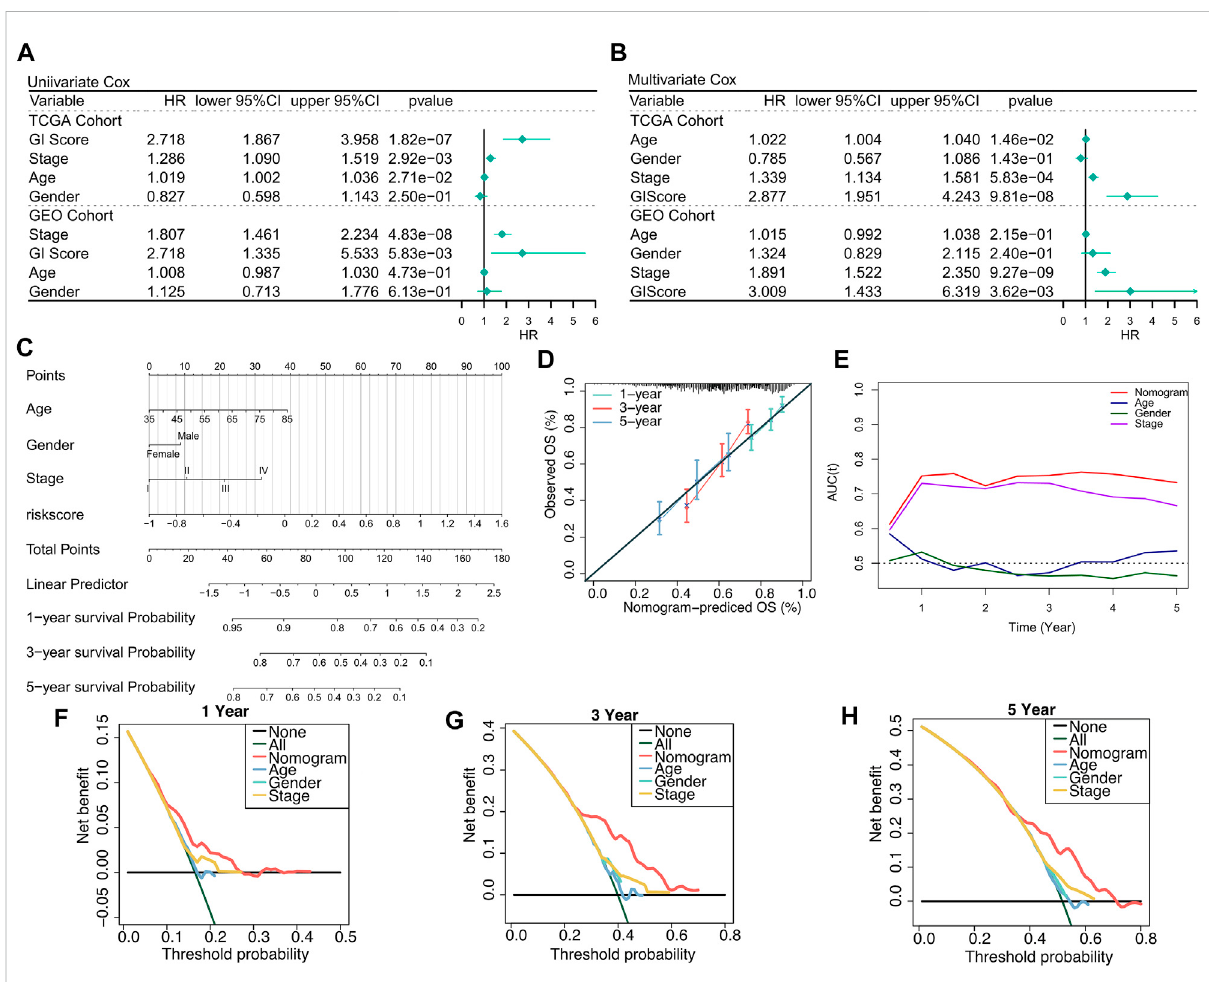
FIGURE 3 Verifying the GIS-related risk model. (A) Univariate Cox regression analysis of GIS and clinical features in the TCGA and GEO datasets. (B) Multivariate Cox regression analysis of GIS and clinical features in the TCGA and GEO datasets. (C) Nomogram based on the GIS model to quantify individualpatientrisk. (D) Nomogramcalibrationcurve. (E) tROCcurvesofnomogramandclinicalfeatures.NomogramDCAcurvesat1 (F) ,3 (G) ,and 5 (H) years. DCA, decision curve analysis; GEO, Gene Omnibus Expression; ROC, receiver operating characteristics curve; GIS, glycolysis – immune score; TCGA, The Cancer Genome